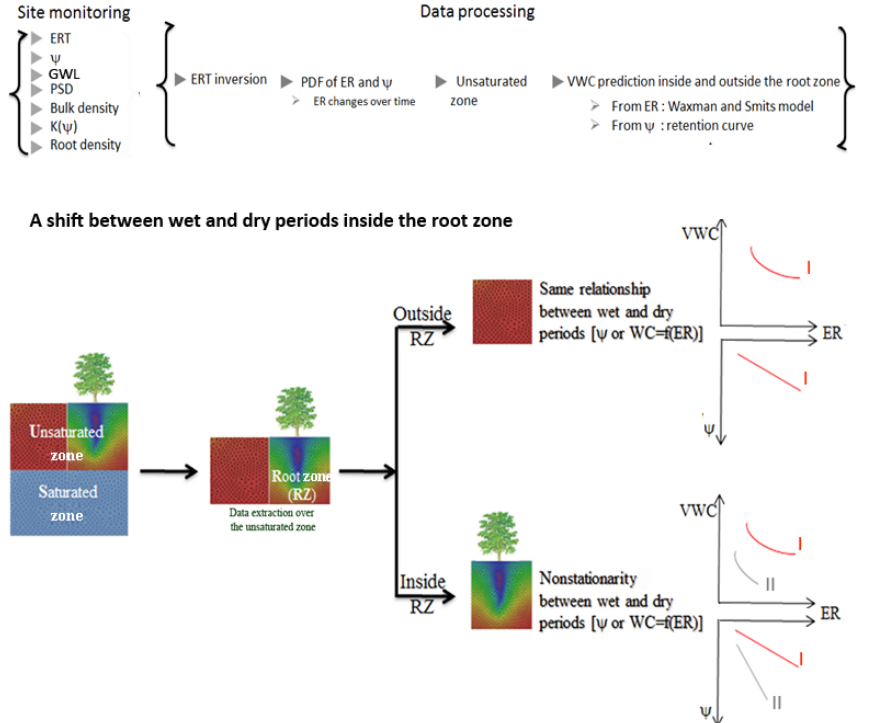
Figure 10. Conceptual diagram summarizing the monitoring setup and the main results, Outside the root zone, the same relationships between ER and VWC (or matric potential) were observed for the wet and dry periods (curve I). Two behaviors (curves I and II) were observed on the locations inside and outside the root